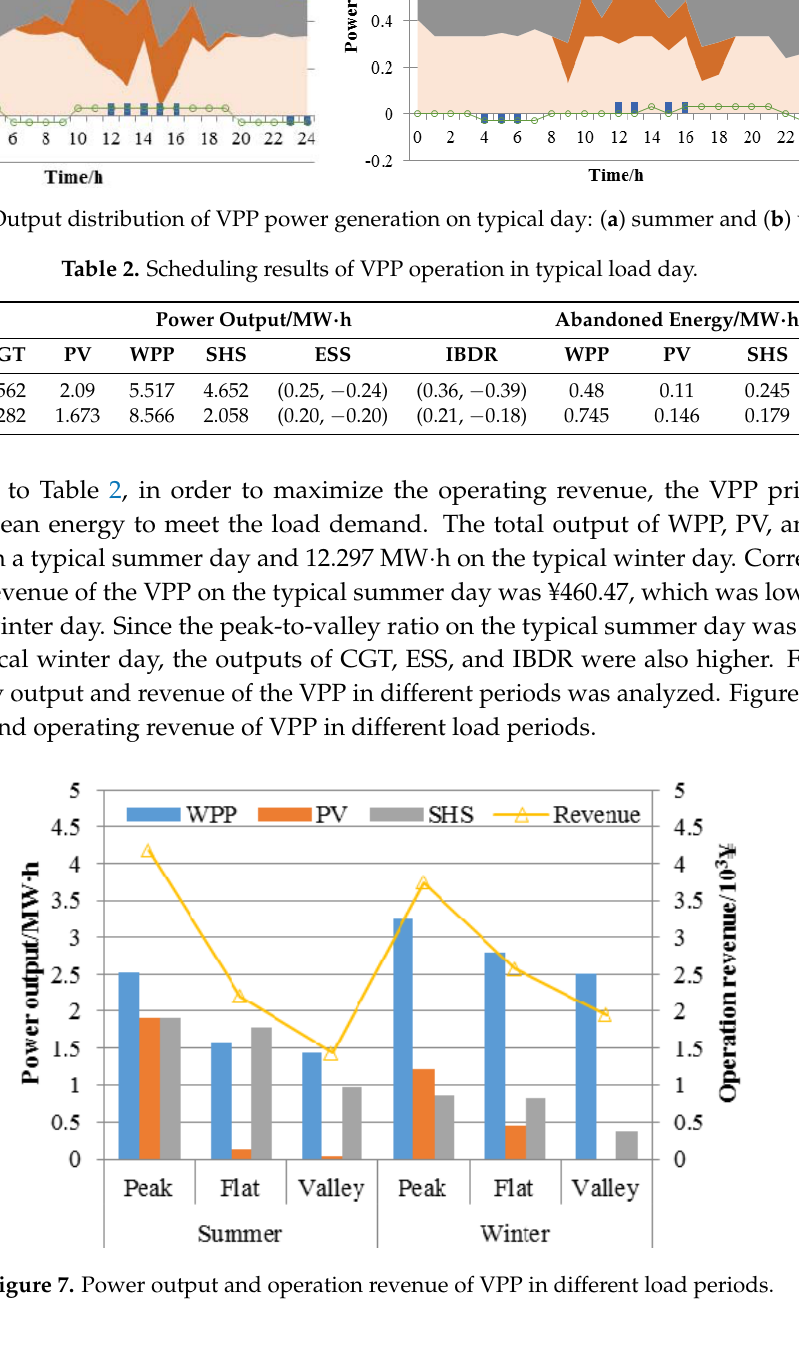
Figure 7. Power output and operation revenue of VPP in different load periods.